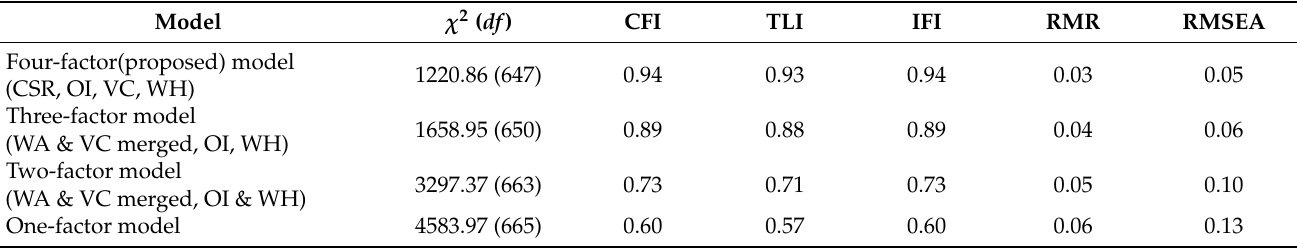
Table 1. Comparison of measurement